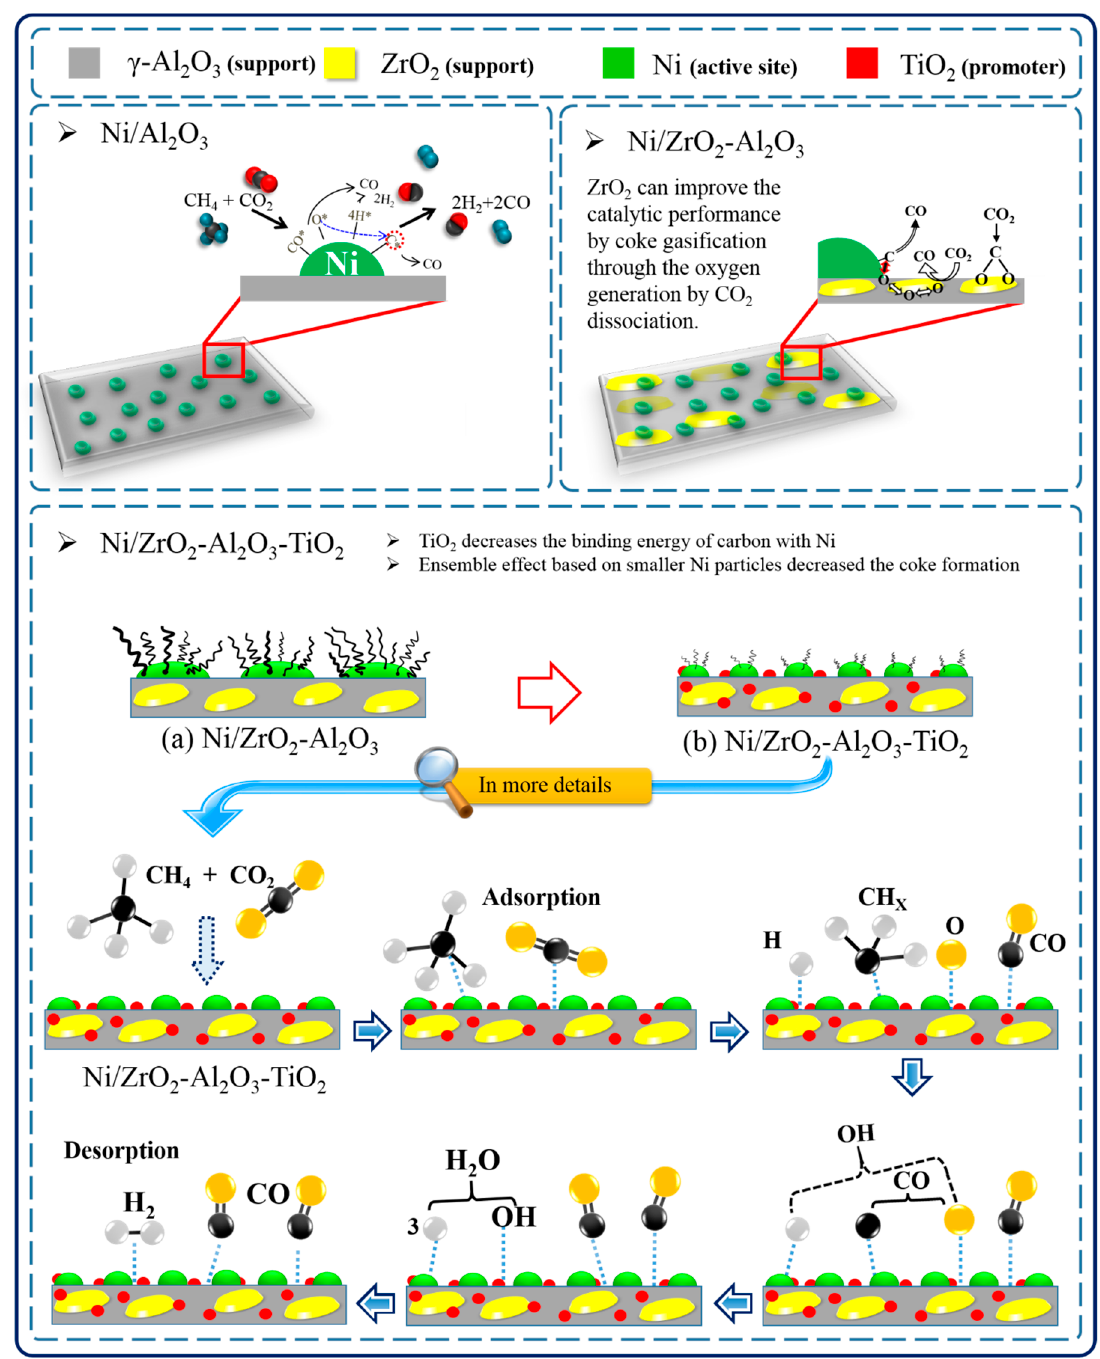
Figure 13. Schematic sketch for mechanism and the role of ZrO 2 and TiO 2 in the Ni/ZrO 2 -Al 2 O 3 -TiO 2 catalyst for the dry reforming of methane.